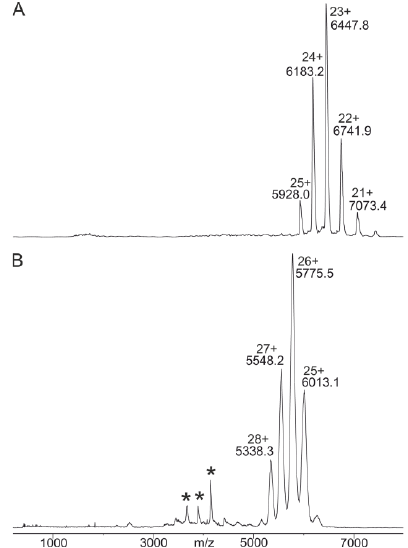
Figure 2. Characterization of anti - Ovalbumin antibody and IgG mix prepared from converted serum. ( A ) Nano - ESI mass spectrum of anti - Ovalbumin antibody (solution 1a). Charge states and m / z values are provided for the multiply charged IgG ion signals. Protein concentration is 0.28 µg/µL. 2.5 µL were loaded. ( B ) Nano - ESI mass spectrum of IgG mix (solution 1b) prepared from mAb-spiked serum. Charge states and m / z values are provided for the multiply charged IgG ion signals. Ion were loaded. Solvent: 200 mM ammonium acetate, pH 6.7. Quadrupole vacuum: 3.2 × 10 − 5